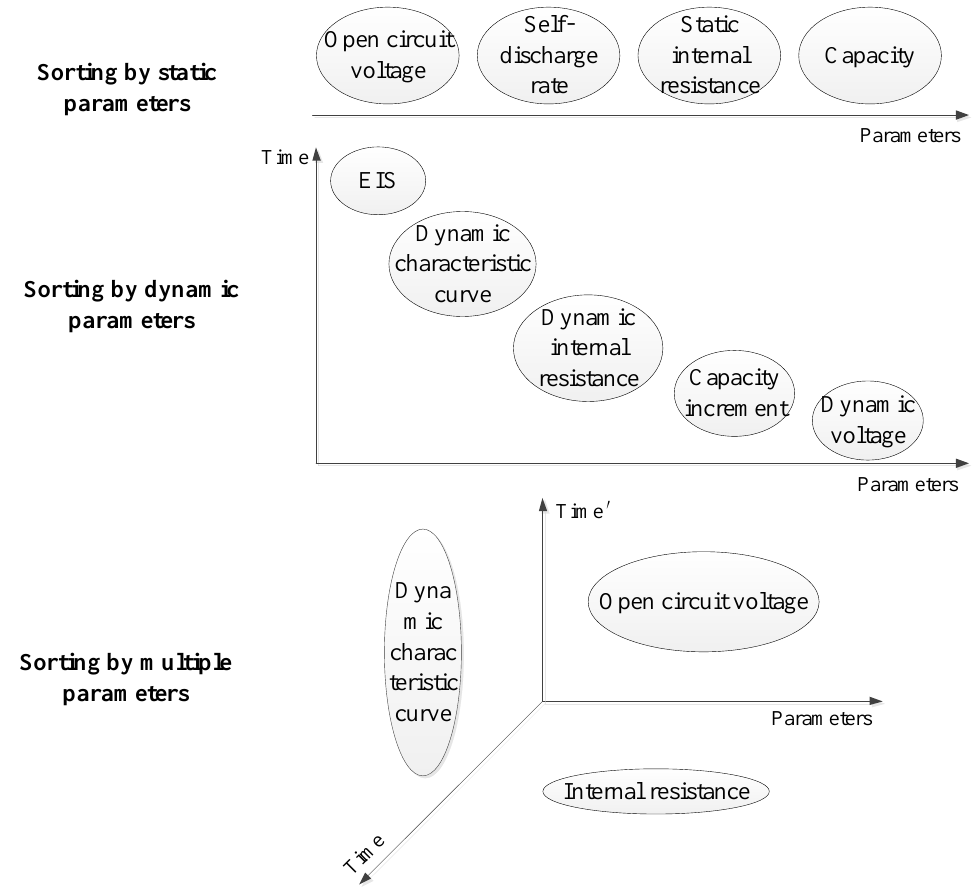
Figure 6. The discharge curve of the battery that meets the sorting conditions.